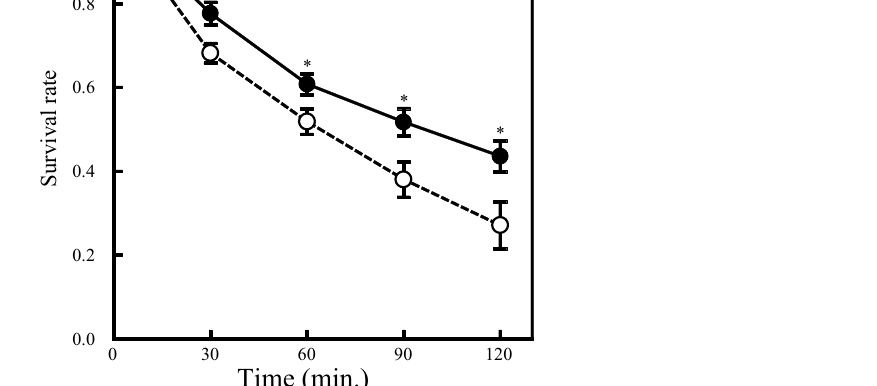
Time (min.) Figure 5. The defensive prowess of soldiers against predatory A. ignipicta larvae. The survival rate of 44 first- instar reproductive individuals introduced into a Petri dish with six soldier aphids and a starved predator was monitored for 2 h. Soldiers from population A were used in 12 Petri dishes, and soldiers from population B were used in 11 Petri dishes. The first-instar reproductive individuals protected by soldiers from population A (filled circle), which had a higher predator density in the wild and soldiers with larger weapons and higher aggressiveness, had a significantly higher survival rate than those collected from population B (open circle), which had a lower predator density in the wild (repeated-measures ANOVA). Symbols and error bars indicate mean ± s.e. Asterisks indicate significant differences between populations (* P <